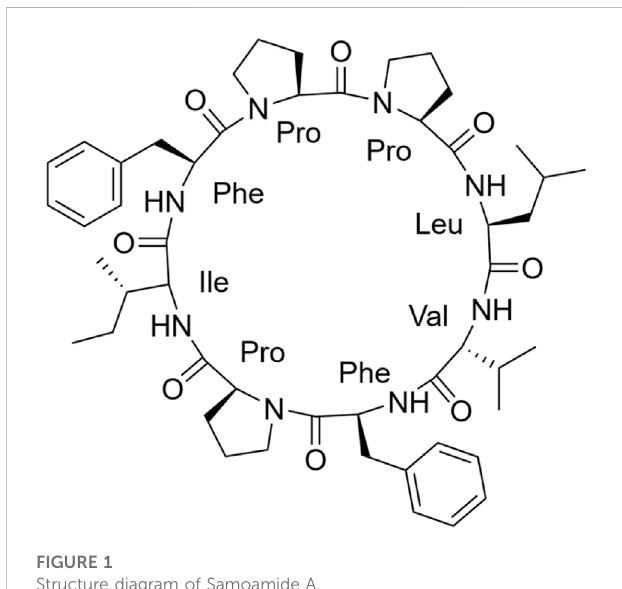
FIGURE 1 Structure diagram of Samoamide